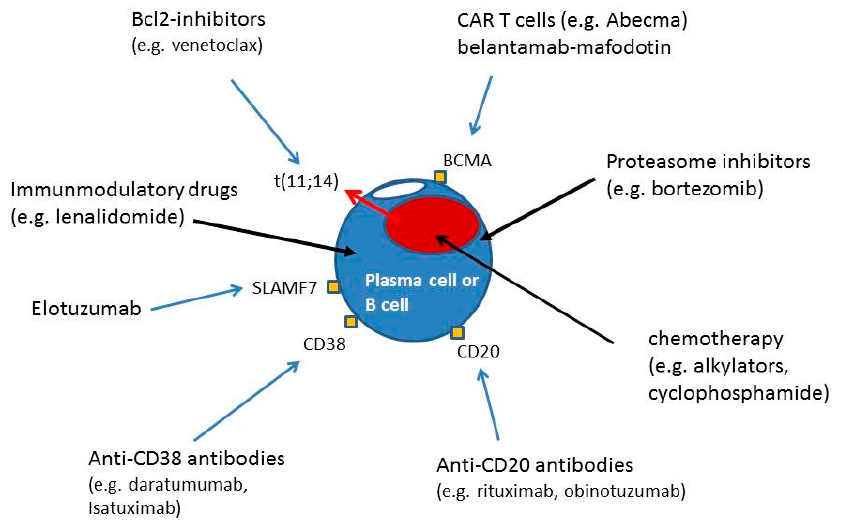
Figure 1. Mechanisms abd drugs to attack the clonal cells in AL